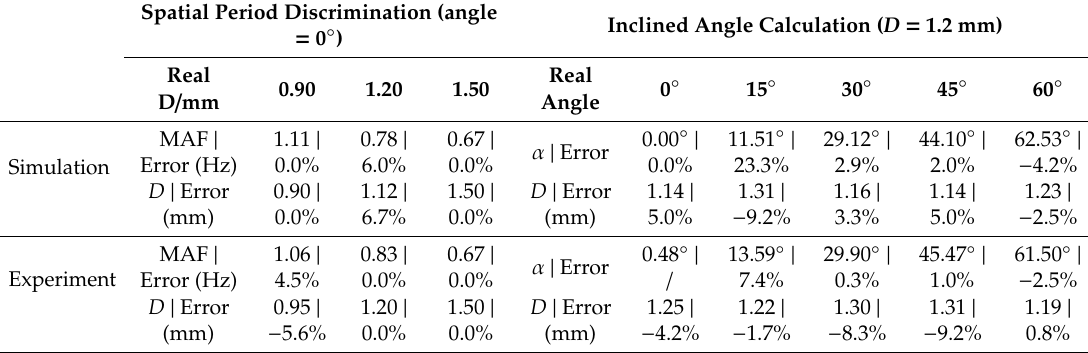
Table 2. Results of calculated spatial period and inclined angle in grooved